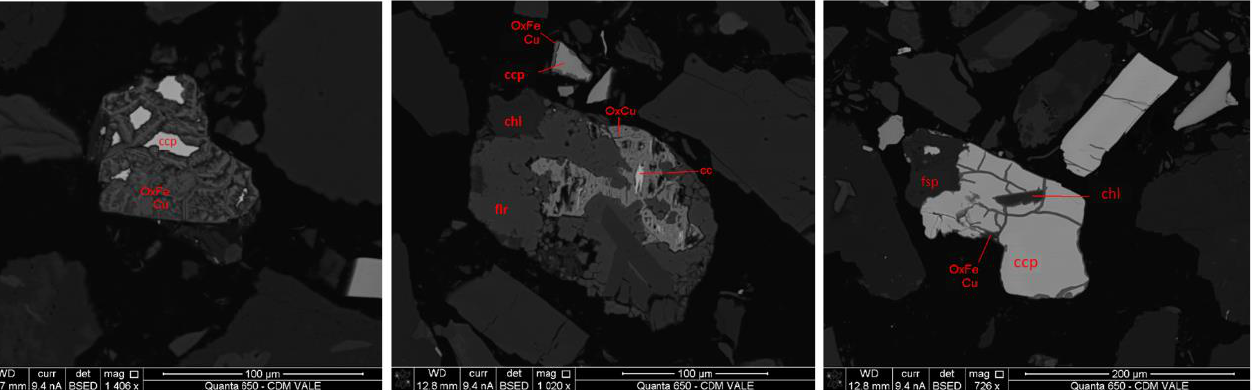
Figure 19. Backscattered electron images of the rougher tailings of sample 5Y-4m-1 × 0, showing grains of chalcopyrite (ccp) partially altered to Cu-Fe oxides, chalcocite (cc), and those associated with silicate particles (chlorite, chl; fluorite, flr; feldspar, fsp). Complete list of acronyms and chemical formulas in Table S1.